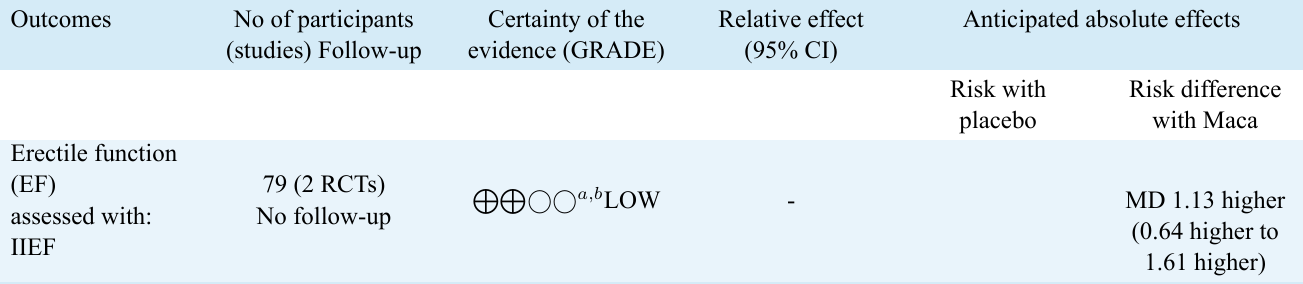
TABLE 2. Summary of